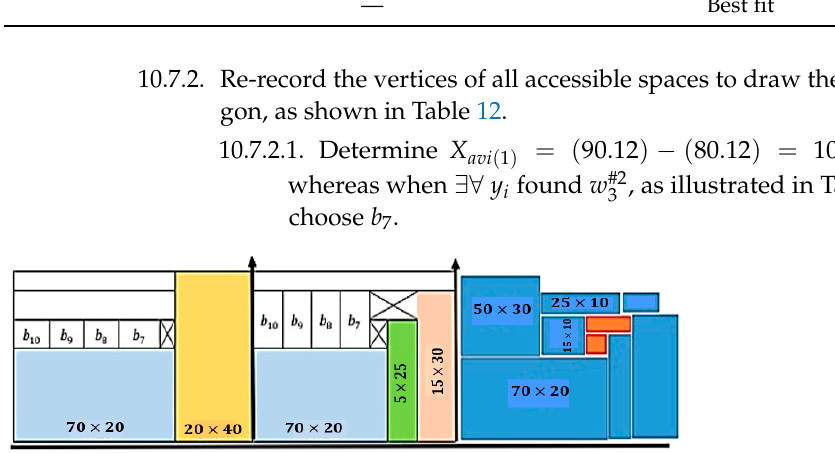
Figure 9. Branch of stowing vertically. Table 12. The vertices of all free space.